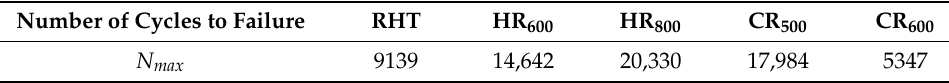
Table 1. The number of cycles to failure for the Fe-30Mn-5Si alloy.